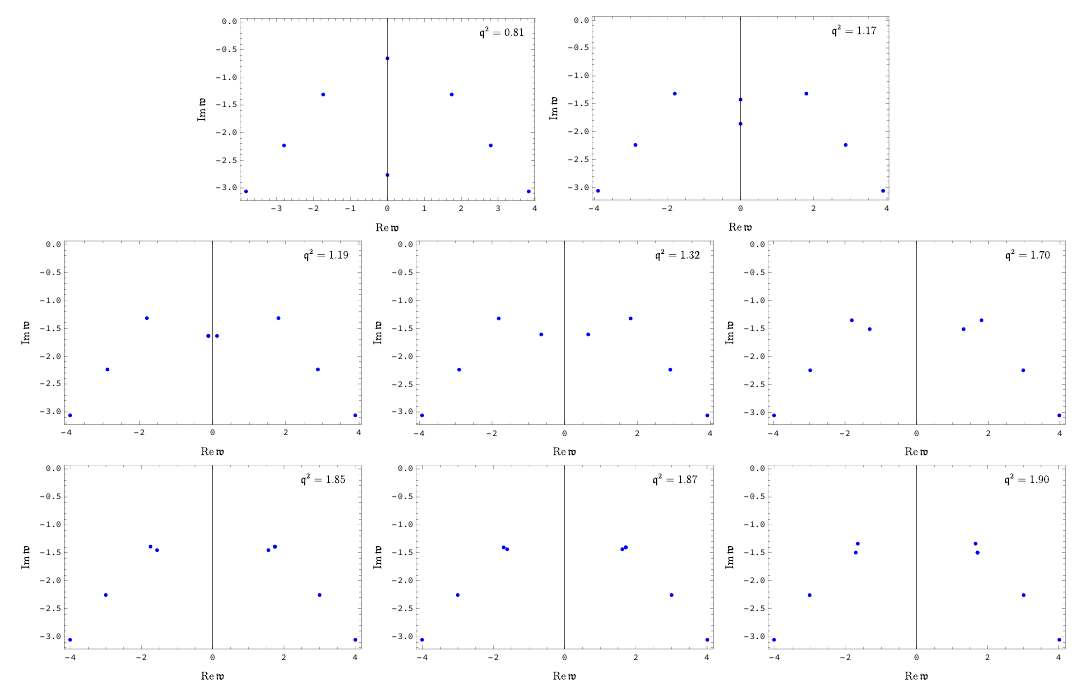
Figure 20 . The non-perturbative quasinormal spectrum in the shear channel of the Einstein-Gauss- Bonnet theory at λ ≈ − 0 . 04956 , plotted for several (increasing) values of q 2 ∈ R . At q 2 = 0 . 81 , GB the shear mode and the non-perturbative mode are present on the imaginary axis; with q 2 increasing, the two modes approach each other on the imaginary axis, collide at the critical point (5.17), move off the axis as the pair of propagating modes (shown in plots with q 2 = 1 . 19; 1 . 32; 1 . 70; 1 . 85; 1 . 87 ) and then collide with the pair of the “Christmas tree” gapped modes at the second critical point (5.18).